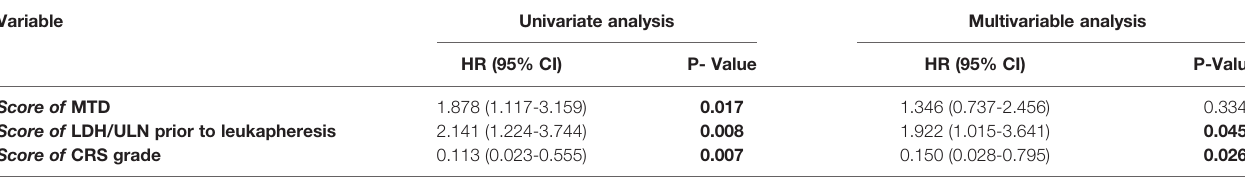
TABLE 4 | Univariate and multivariate forward stepwise regression analysis.